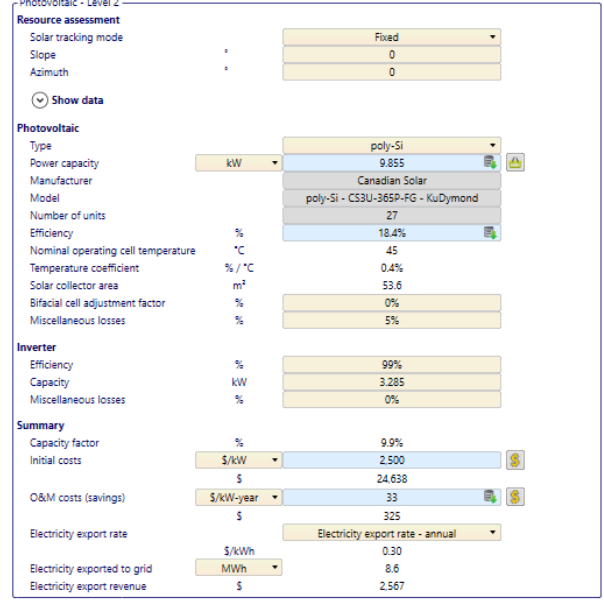
Figure 7. Energy data input for the case of London, United Kingdom.